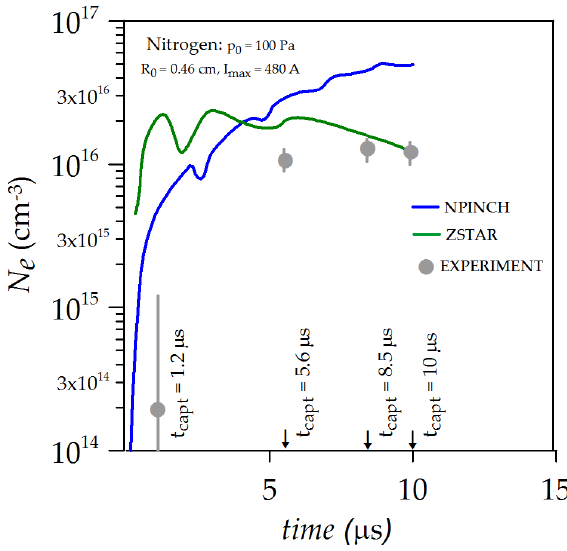
Figure 10. Time dependencies of electron density Ne on the axis evaluated according to NPINCH code (blue line), ZSTAR code (green line) and experimental values at selected moments of time (gray